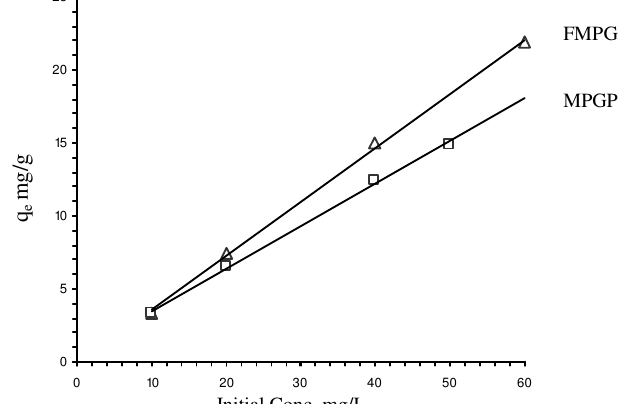
Figure 2. Relation between amount of Cr(VI) adsorb at equilibrium, qe, and Its initial conc. using MPGP, 0.1 g/50 mL, at pH 2, time 80 min., and FMPGP, 0.1 g/50 mL, at pH 3, time 100 min. temperature 30 0